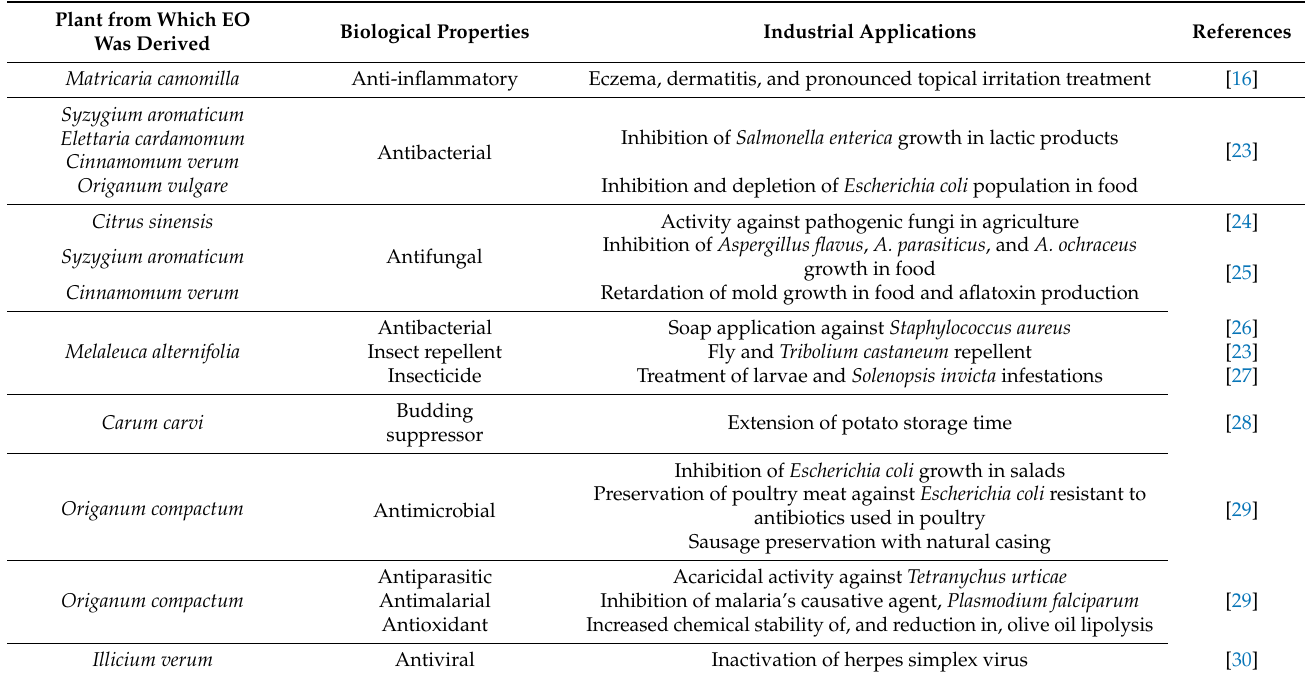
Table 1. Biological properties of EO and their industrial